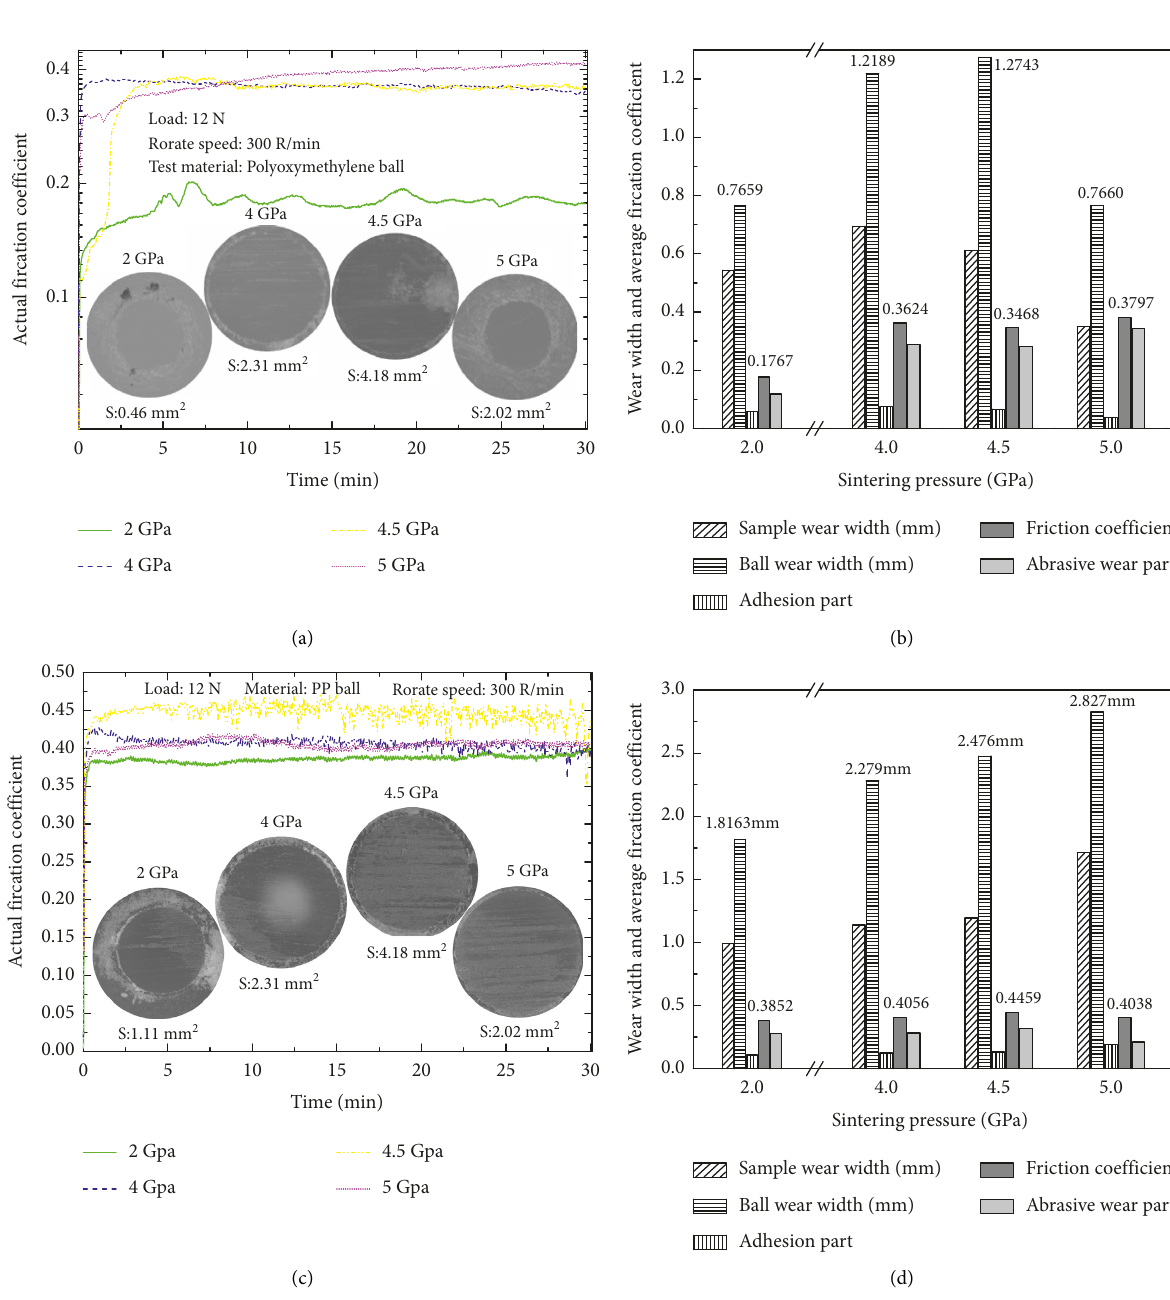
Figure 5: Friction coefficient (a) and wear properties (b) of synthetics and POM pairs; friction coefficient (c) and wear properties (d) of synthetics and PP